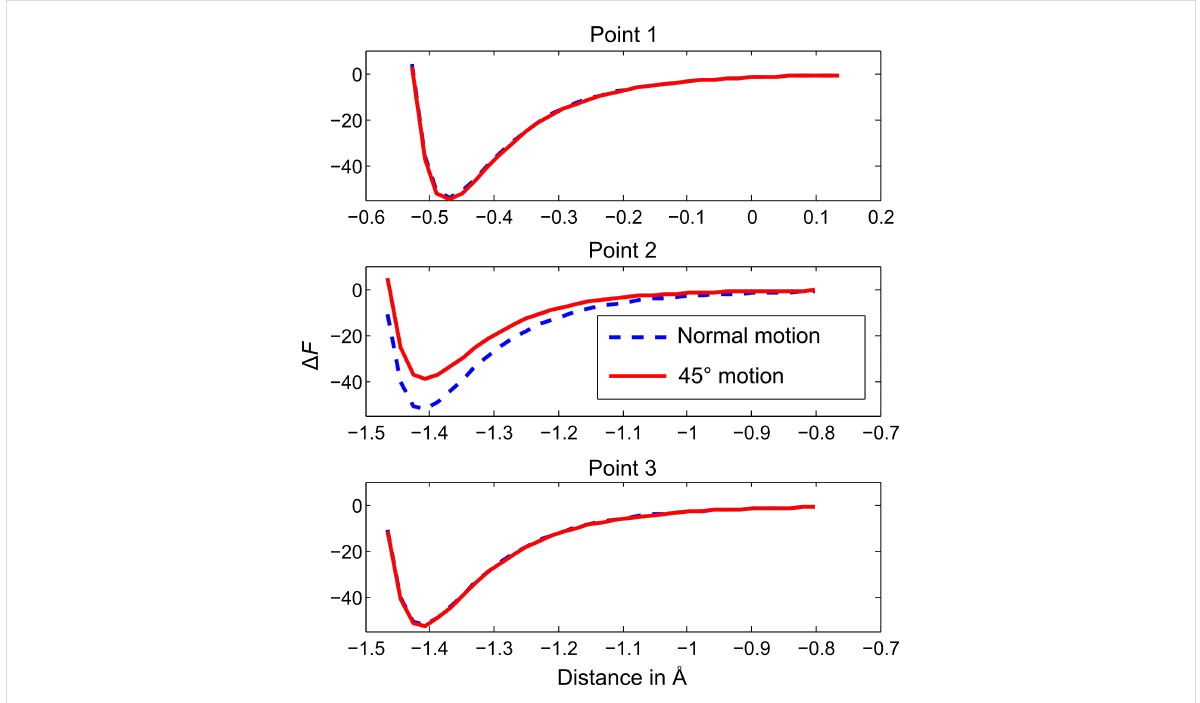
Figure 5: Effect tip motion on spectroscopy for an oscillation amplitude of a z = 5 Å. Simulated spectroscopy measurements taken at three points as marked on Figure 4a. These show that only when the tip apex moves through significant lateral forces does the angle of scan have a noticeable effect on the z